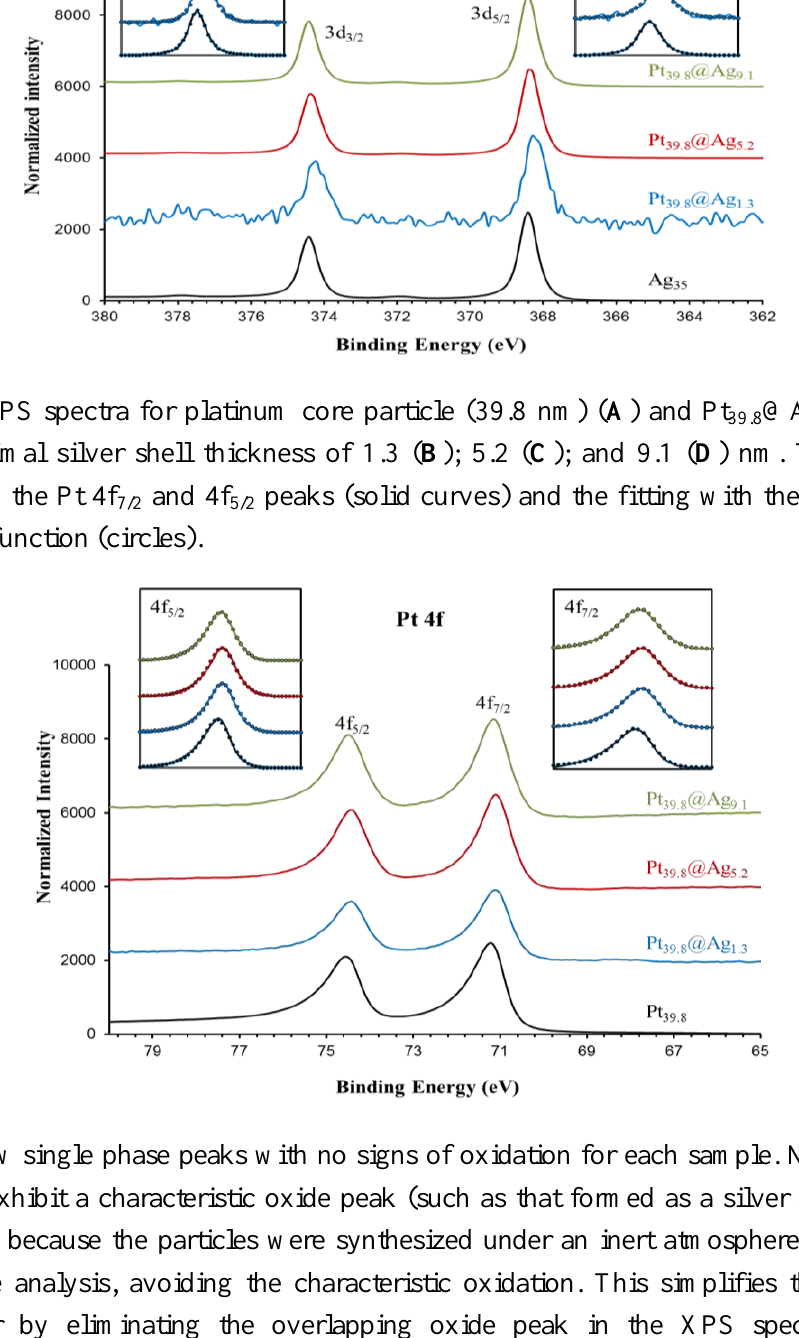
Figure 8. XPS spectra for platinum core particle (39.8 nm) and Pt an optimal silver shell thickness of 1.3; 5.2; and 9.1 nm. The inserted graphs show the Pt 4f and 4f peaks (solid curves) and the fitting with the asymmetric G-L mixed 7/2 5/2 function (circles).